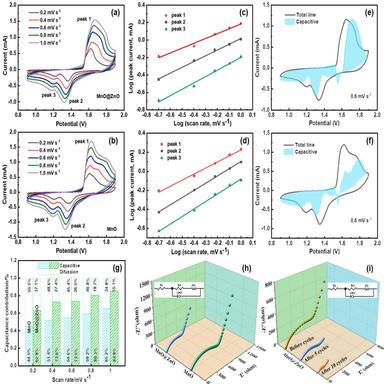
Reaction kinetics analysis of MnO and MnO@ZnO: (a, b) CV curves, (c, d) The linear relationship of log(i) vs. log(v), (e, f) Typical CV curve displaying the capacitive contribution (cyan area) to total current at 0.5 mV s − 1 . (g) Contribution ratios of capacitive and diffusion-controlled capacities at different scan rates. (h) Nyquist plots. (i) Nyquist plots of the MnO@ZnO after different cycles.